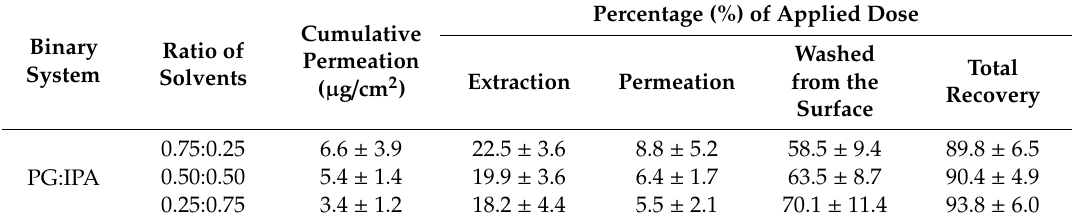
Table 2. Cumulative permeation and percentage (%) recovery values of EA for various PG:IPA solvent systems following mass balance studies ( n ≥ 4; mean ±